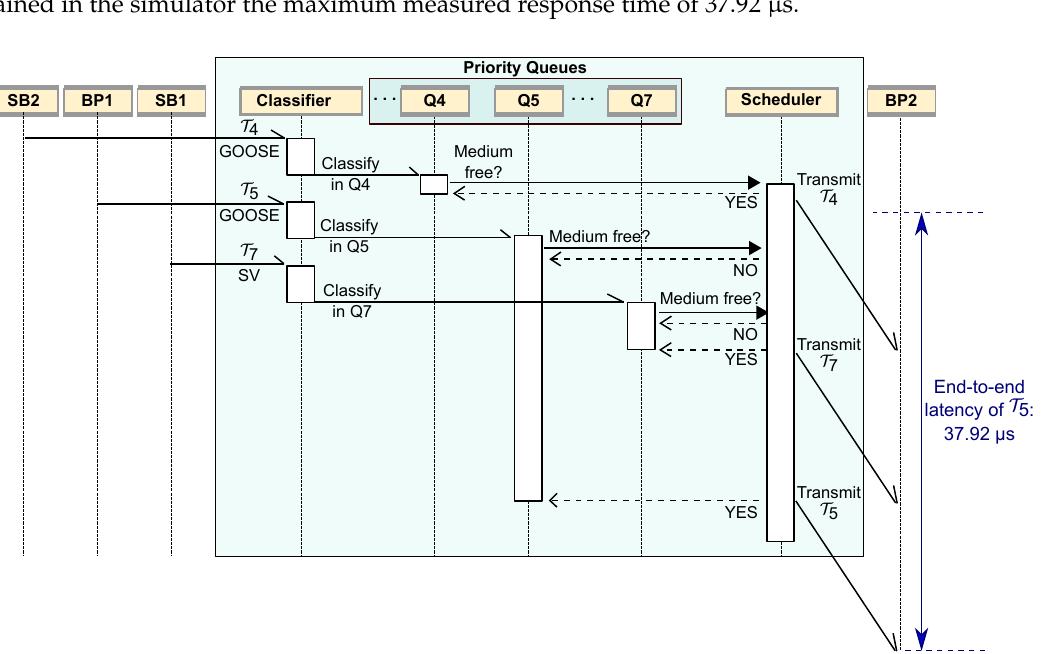
Figure 8. A scenario extracted from the simulator in which a GOOSE message sent by BP1 message reaches its maximum end-to-end latency.